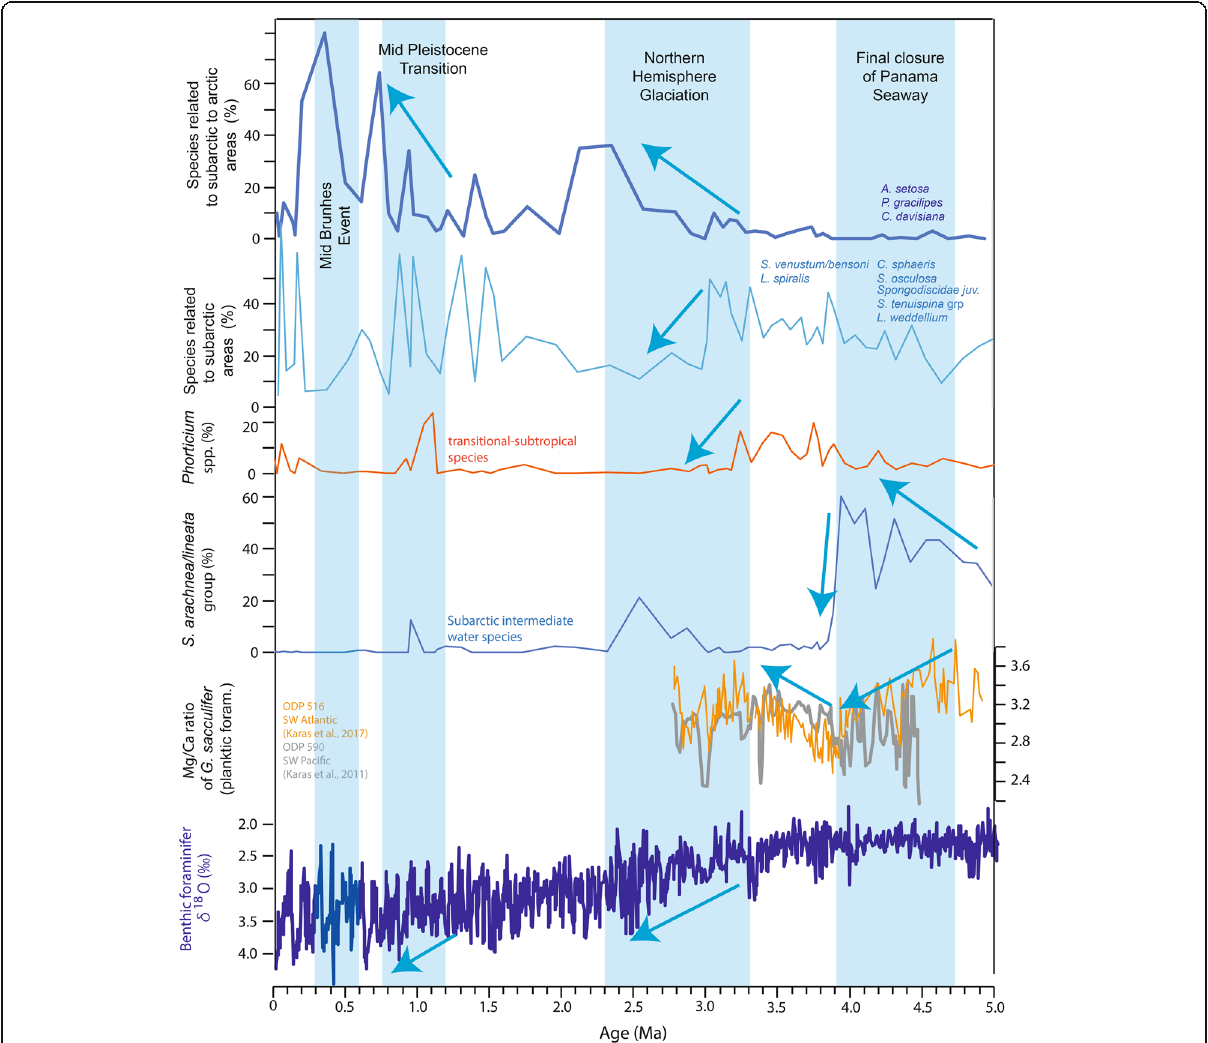
Fig. 9 Details of the paleoceanography of the Japan Sea between 5 and 0 Ma. We compare relative abundances of S. arachnea/lineata group, Phorticium spp., and species related to subarctic and arctic areas (the selected species are listed at the upper right in the figure) from Site U1425. These data are compared to Mg/Ca ratio data for plankton of the South Pacific and Atlantic (ODP 516/590, Karas et al. 2011, 2017) and